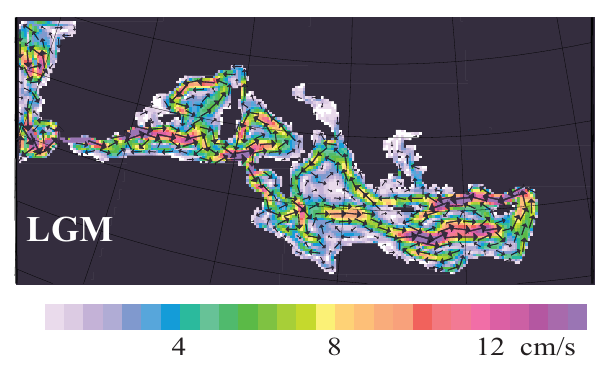
Fig. 13. Currents at 27m depth for LGM. Colours indicate the flow speed in cms − 1 , vectors both direction and speed. Only a subset of vectors has been plotted. For CTL see Fig.